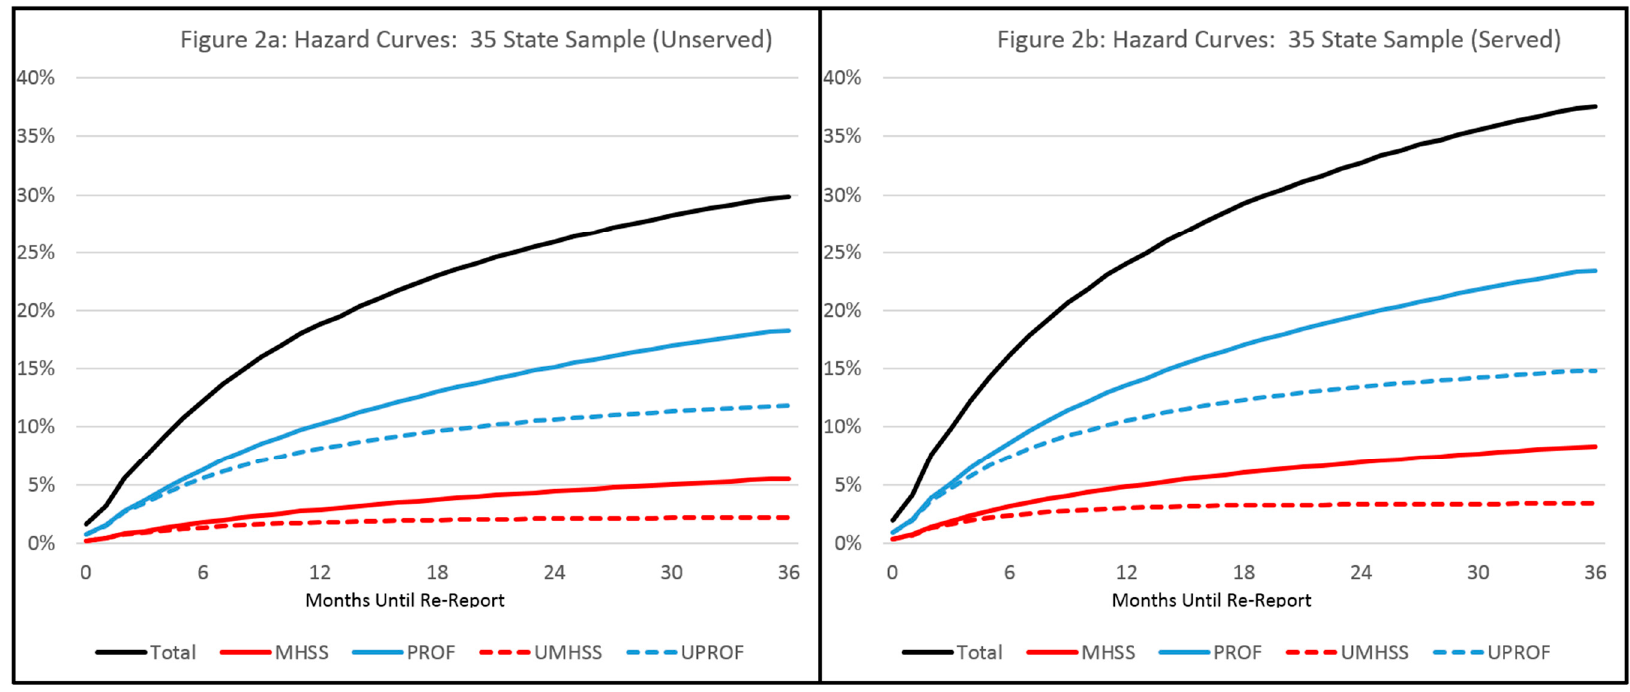
Figure 2. Hazard curves, percentage with re ‐ report by re ‐ reporter type: ( a ) Unserved cases; ( b ) Served cases. Note: “MHSS” indicates a mental health or social services reporter, “PROF” indicates any professional reporter (including MHSS), the prefix “U” indicates that the source was uniquely from that reporter type (e.g. “UMHSS” means reports were made only by a MHSS source or sources).